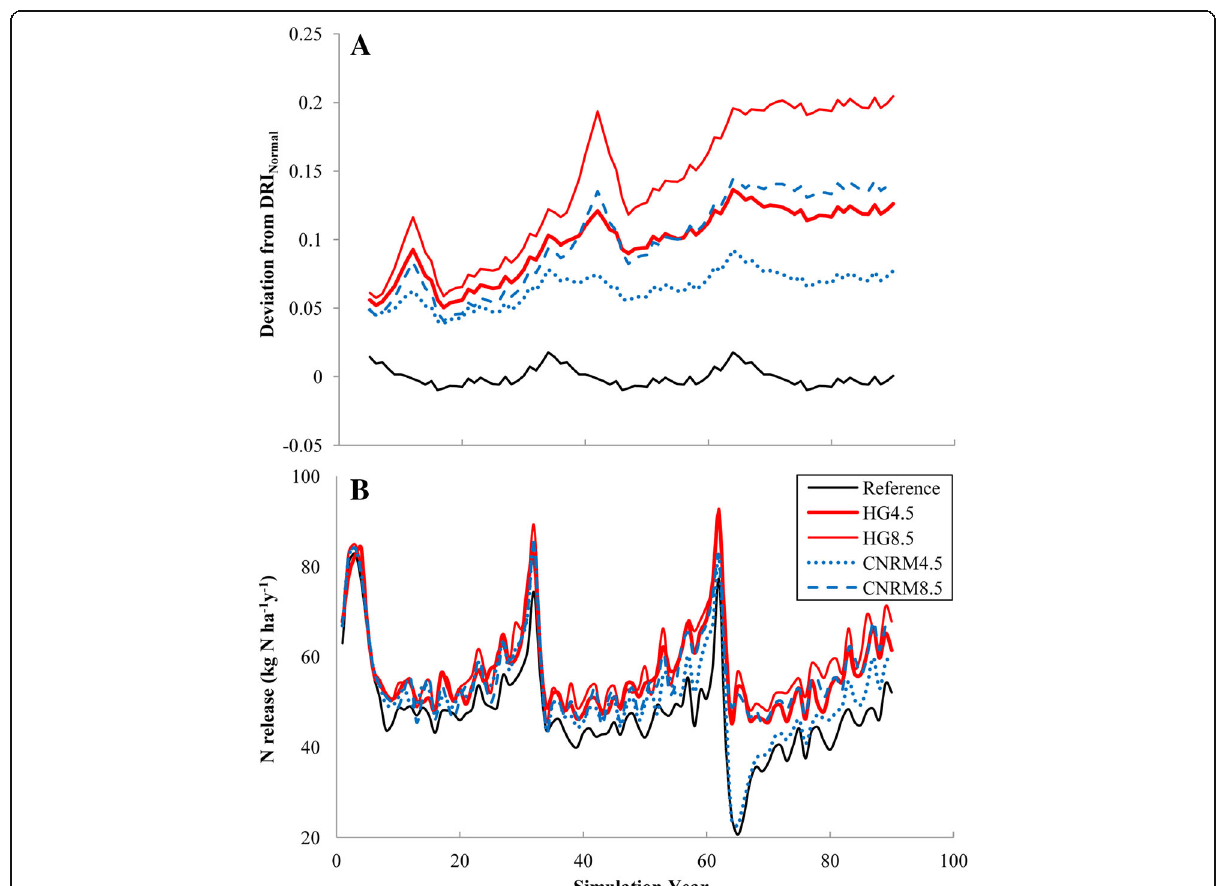
Fig. 9 Simulation results showing the effects of climate change on decomposition rate ( a ) and litter nitrogen release ( b ). The lines in a represent 5-year moving